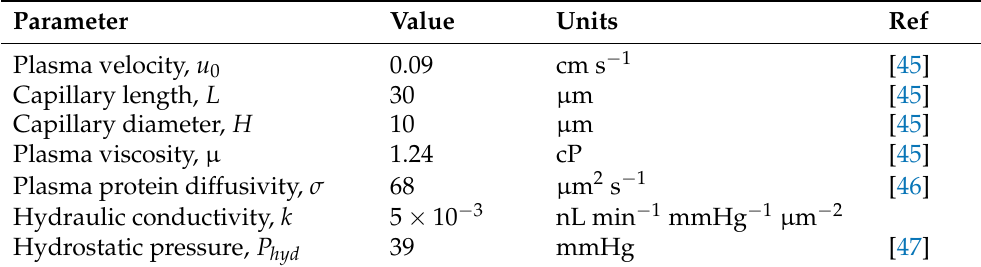
Table 5. Parameters for glomerular capillary